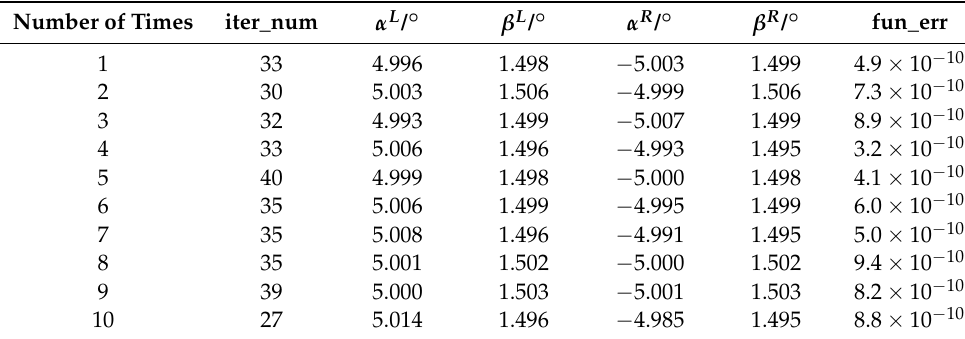
Table 1. “iter_num” represents the number of iterations for which the gaze-constraint error was less than the iteration termination error, and "fun_er" represents its corresponding gaze-constraint error. Table 1. Kappa angles obtained from 10 calibrations. Number of Times